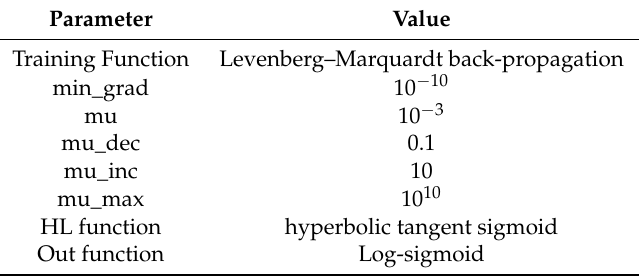
Table 9. Parameters of the ANN(Data from [33]).